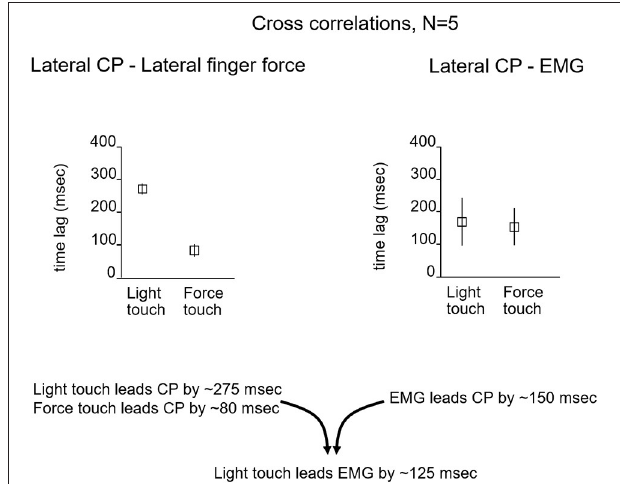
FIGURE 3 | The relationship between the lateral CP and fingertip force changes and EMG activity that leads to CP changes. For light-touch, force changes at the fingertip lead EMG activity by 125ms and CP changes by ≈ 275ms. The EMG reflects muscle activation that 150ms later alters the CP to counteract body sway. With force touch, changes in applied finger force lead CP changes by ≈ 80ms, indicating some mechanical stabilization by the finger force